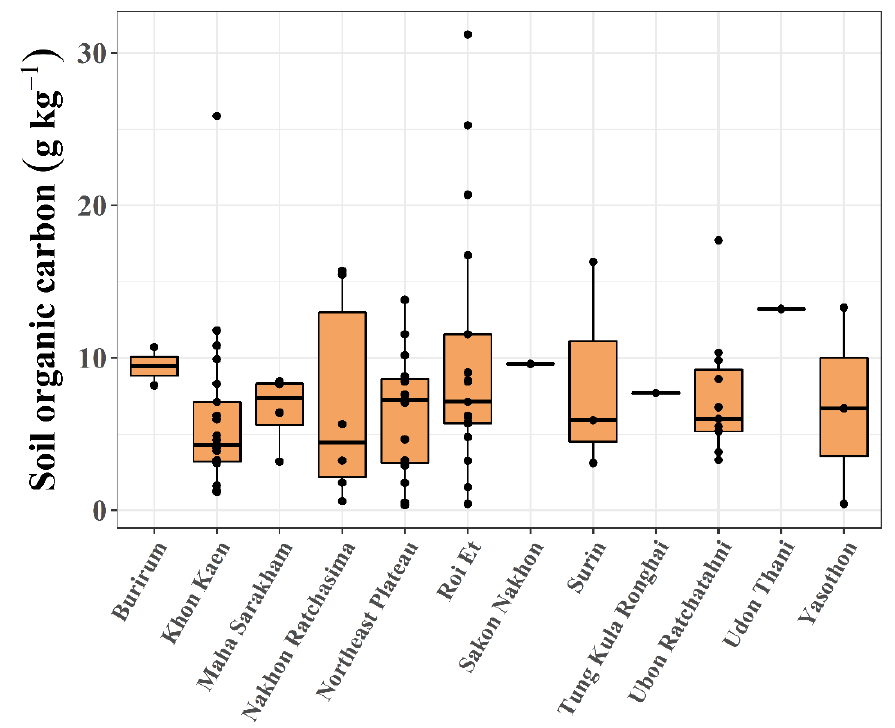
Figure 2. Overview on soil organic carbon (g kg − 1 ) (within the range of 0–40 cm depth) distribution in rice-based cropping systems of each area in Northeast Thailand ( n = 89) [41,49–70].